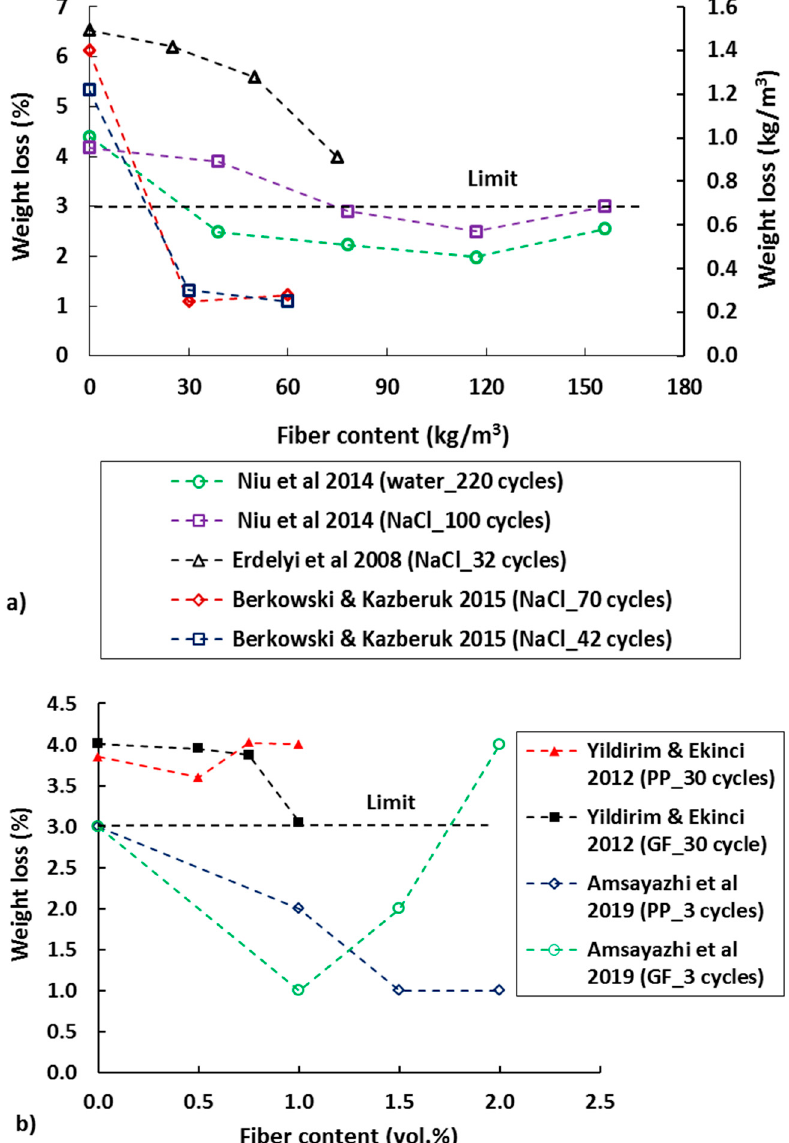
Figure 6. Weight loss of ( a ) steel-fiber FRC specimens and ( b ) polypropylene (PP) and glass fiber (GF) specimens’ solution under different freeze-thaw cycle (adapted from [120–124] ).